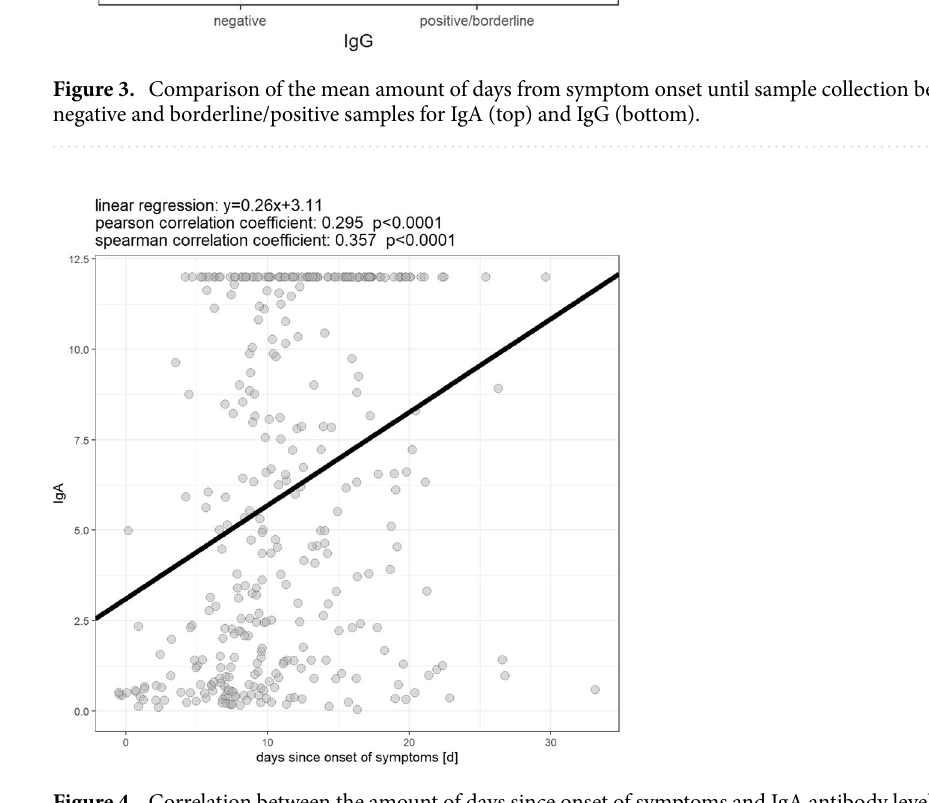
Figure 4. Correlation between the amount of days since onset of symptoms and IgA antibody